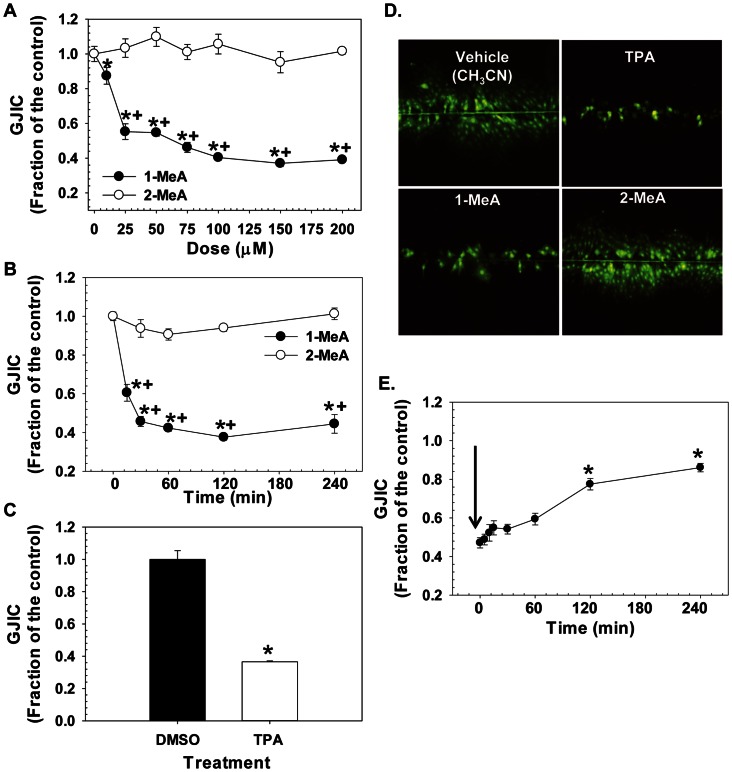
Dose response, time course, and recovery studies following treatment with 1-and 2-MeA.(A) Dose response for 1 and 2-MeA from 0–200 µM. Acetonitrile (CH3CN) is the vehicle control for the PAHs for all studies. (B) Time course following treatment with 1 and 2-MeA from 0–4 h. 1-MeA (75 µM) and 2-MeA (200 µM). (C) TPA positive control (50 nM, 60 min) for GJIC dysregulation in C10 cells. DMSO is the vehicle control for the TPA. Mean ± SEM presented in A–C with n = 3 per study, replicated 3 times. 1-MeA, 1-methylanthracene; 2-MeA, 2-methylanthracene. *p<0.05 compared to control; +p<0.05 compared to 2-MeA treated cells at the same concentration or time point. (D) Depiction of SL/DT assay after 30 min incubation with vehicle control (CH3CN), TPA (50 nM), 1-MeA, and 2-MeA treatment both at 75 µM demonstrating the lucifer yellow dye incorporation into the C10 cells that are communicating via gap junctions. DAPI was used for nuclear staining. Magnification at 100X. (E) Time to recovery for reversal of GJIC dysregulation in C10 cells following a 30 min treatment with 1-MeA. Black arrow indicates the removal of 1-MeA and replacement with serum-free media. Some recovery was observed approximately 1 h following removal of 1-MeA and continued through 4 h, although complete recovery was not seen. Mean ± SEM presented with n = 3 per study, replicated 3 times. *p<0.05 compared to C10 cells at 0 time point which is 30 min following 1-MeA treatment.